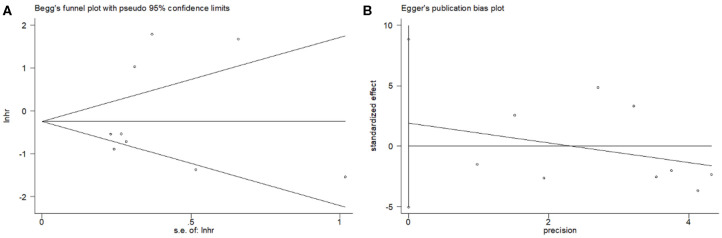
Publication bias tested by (A) Begg's test and (B) Egger's test for OS.